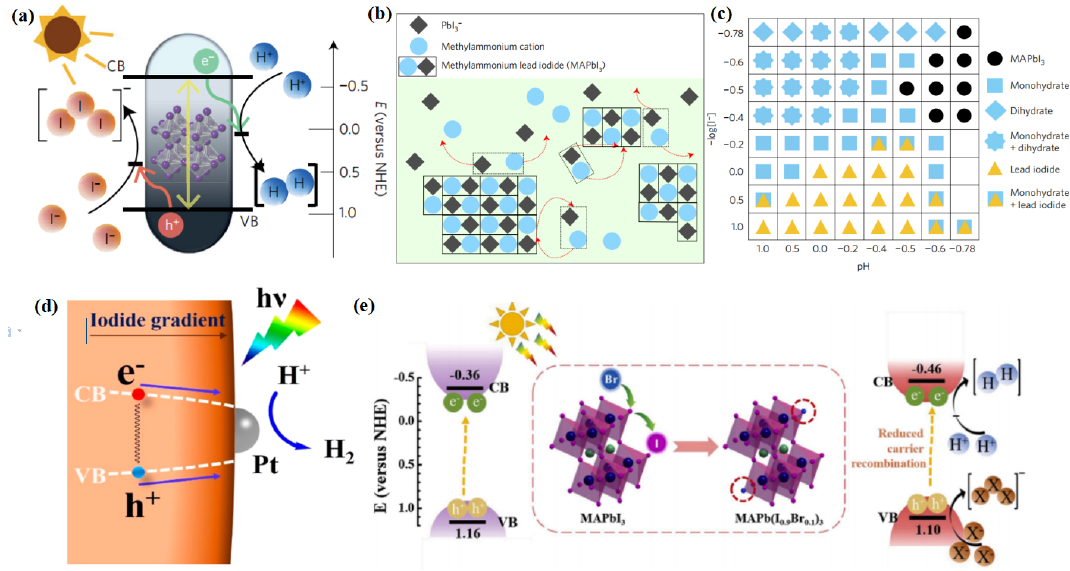
Figure 3. ( a ) Schematic energy band structure of MAPbI 3 powder for the photocatalytic HI splitting reaction. ( b ) Schematic illustration of the MAPbI 3 powder in dynamic equilibrium in saturated HI solution. The red color arrows represent dissociation and reprecipitation of MAPbI 3 crystal and